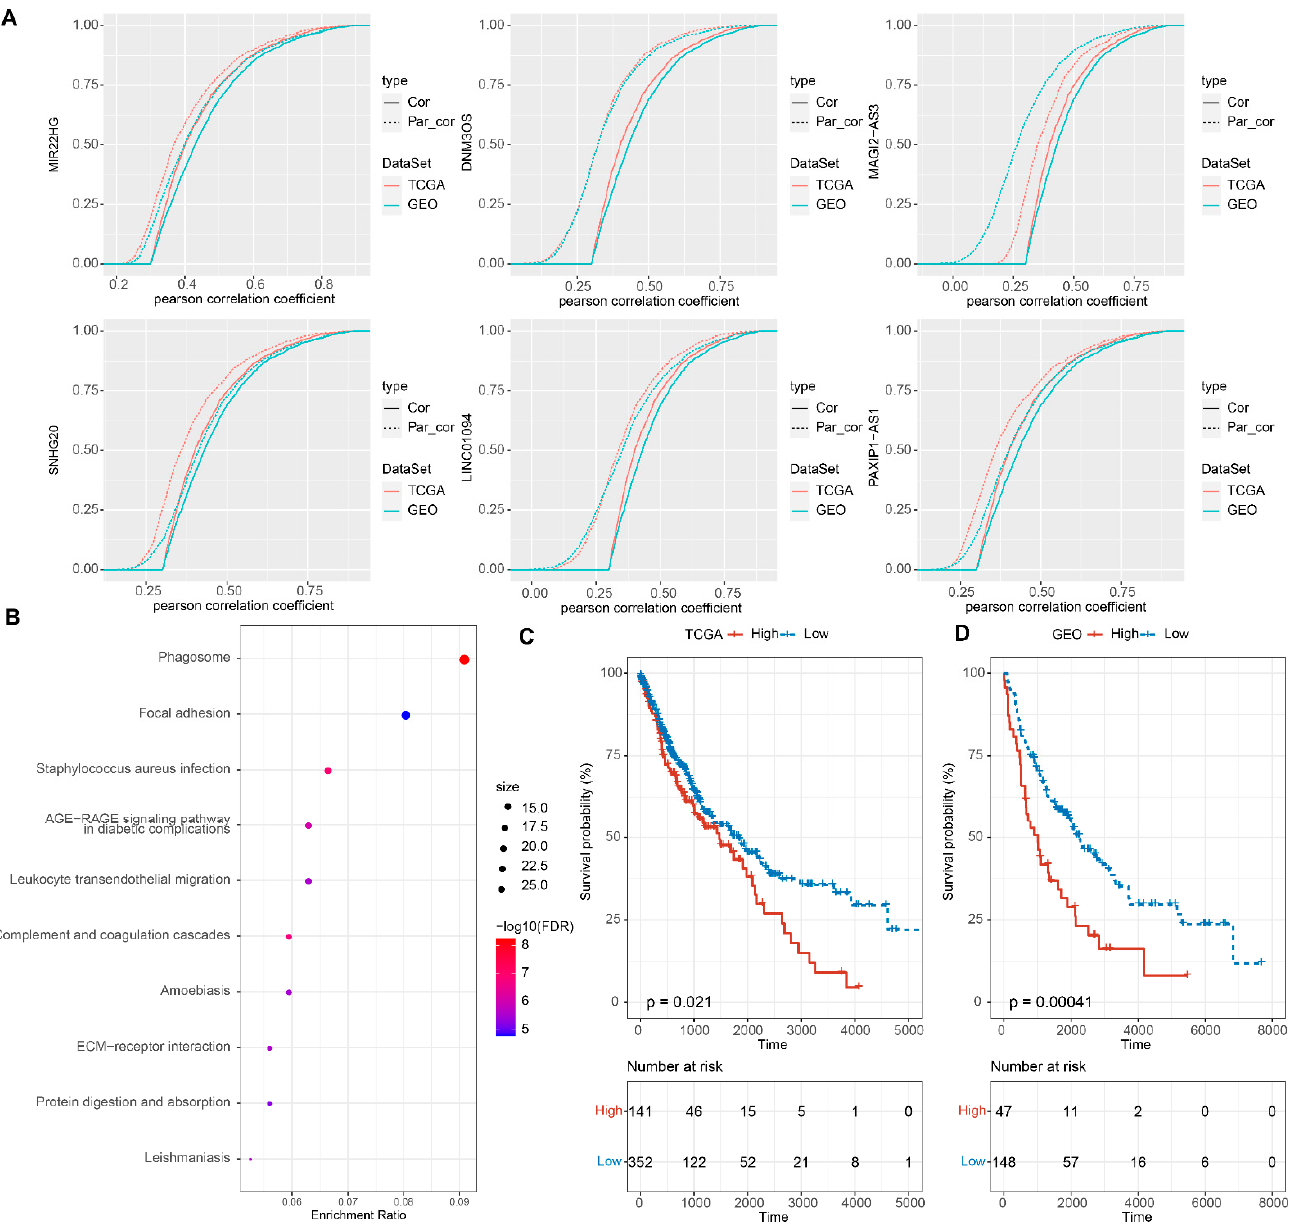
Figure 8. Identification of key EMT-associated lncRNAs. ( A ) CDF with or without adjustment for EMT-associated lncRNAs by using a first order partial correlation. Solid lines indicate CDFs of correlation coefficients between glycolysis scores and gene expressions without adjustment. Dashed lines indicate first-order partial correlation-adjusted relations between glycolysis scores and gene expressions. These two distributions were compared using the Kolmogorov–Smirnov test. The x -axis represents Pearson correlation coefficients between glycolysis scores and gene expressions, and the y -axis represents cumulative probabilities. ( B ) Enrichment analysis of genes significantly associated with lncRNAs. ( C ) KM curves of high- and low-risk groups in the TCGA cohort. ( D ) KM curves of high- and low-risk groups in the GEO